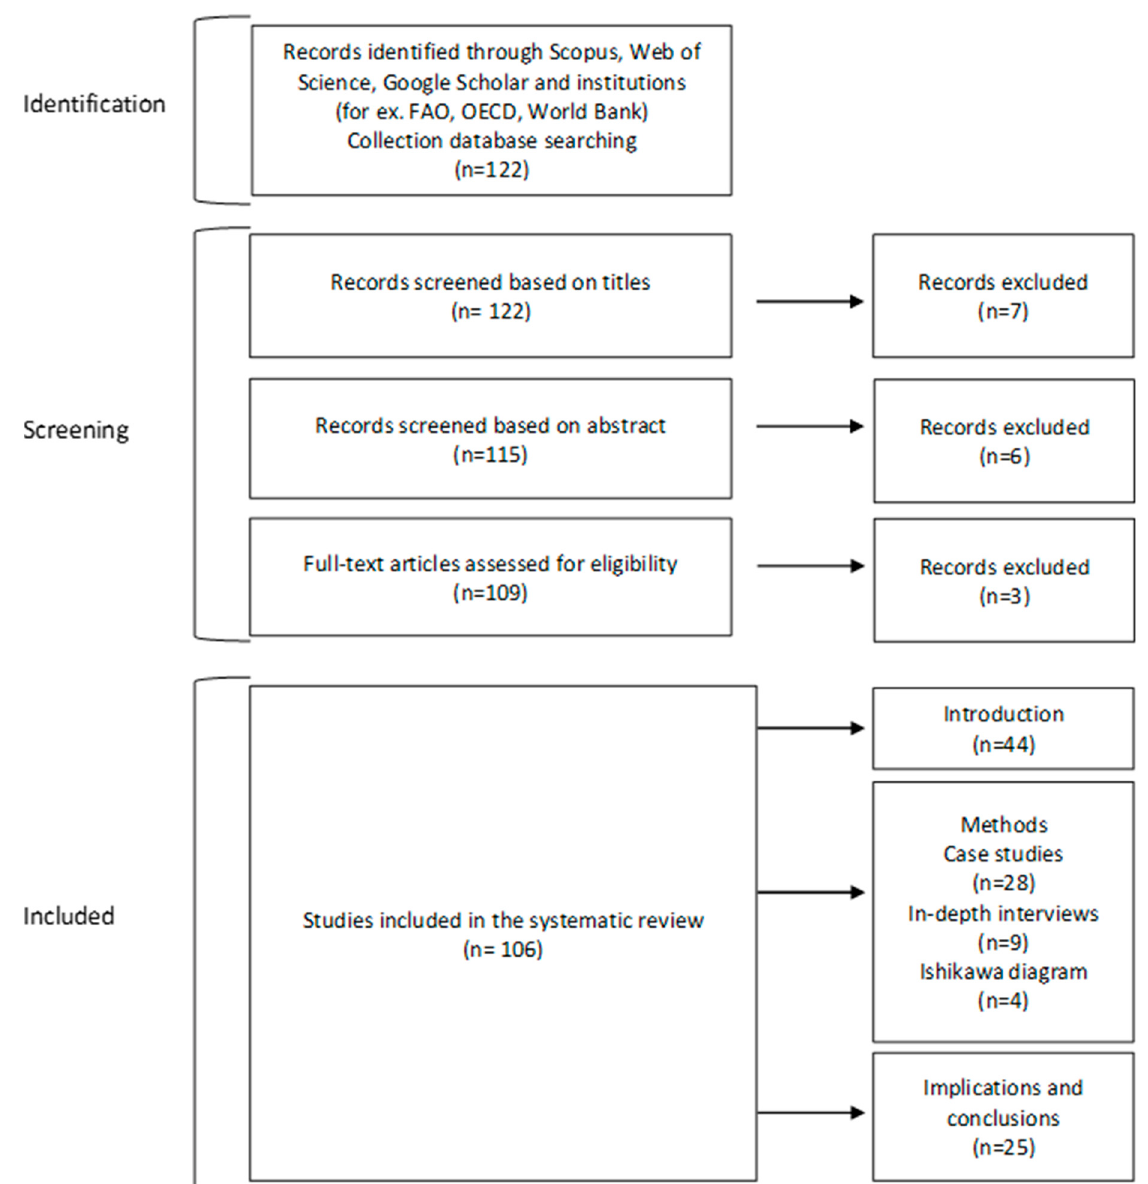
Figure 1. Selection of secondary sources according to PRISMA guidelines.